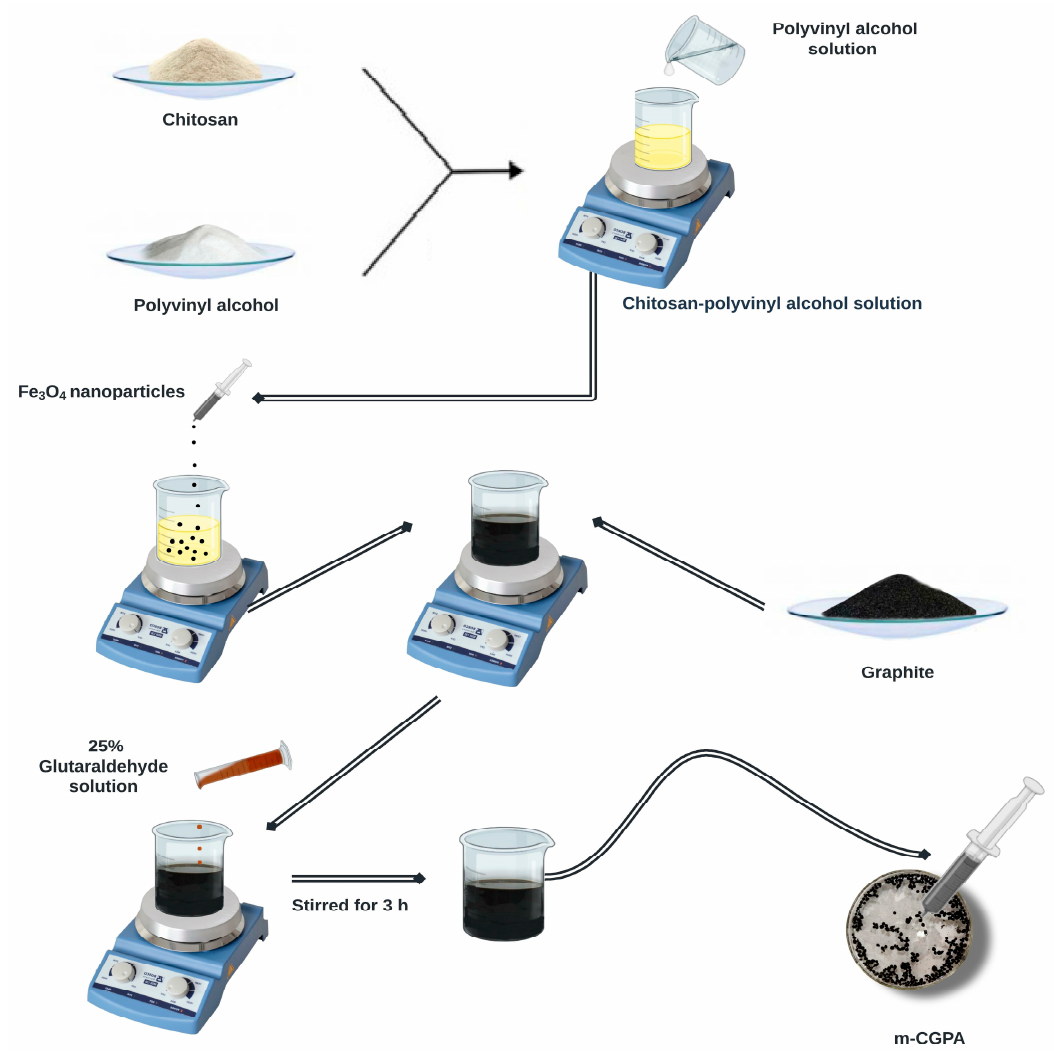
Figure 1. Schematic representation for the synthesis of